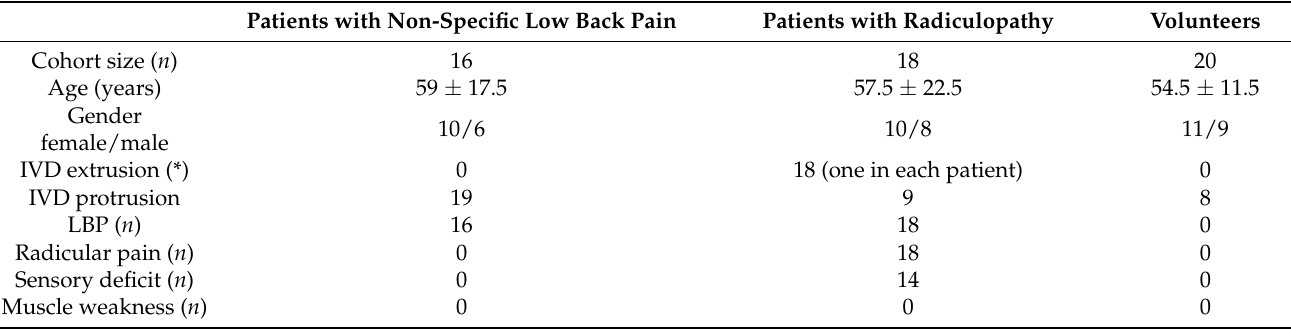
Table 1. Demographic and clinical information of the study